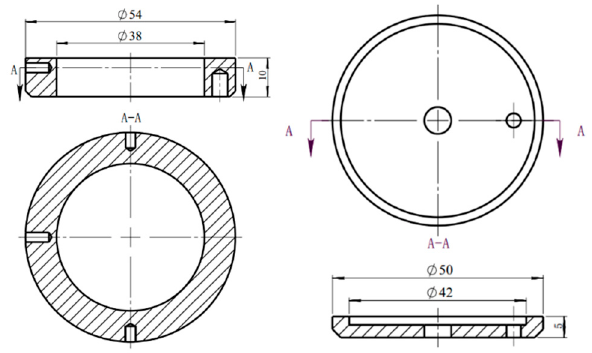
Figure 3. The size of the experimental materials.